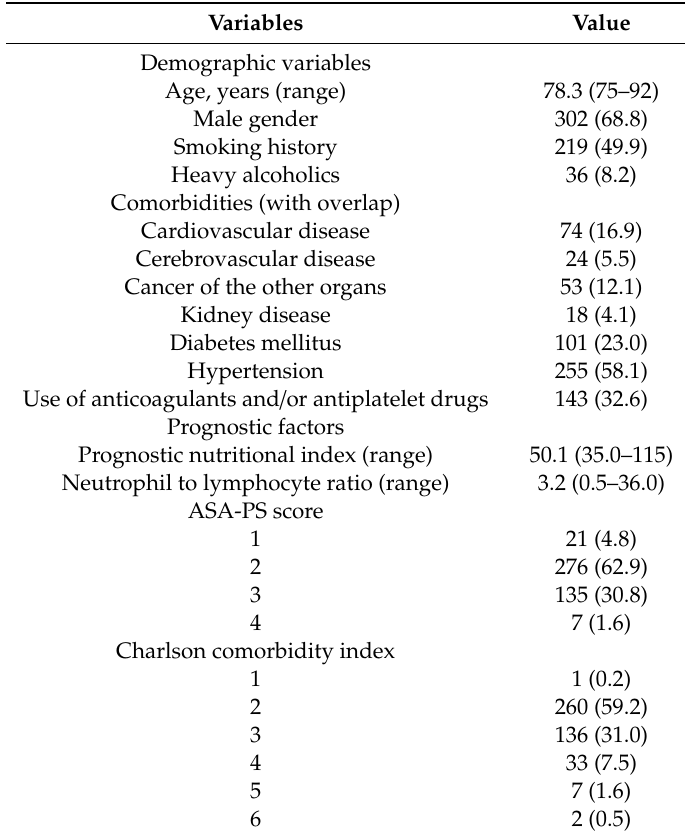
Table 1. Baseline characteristics of the 439 patients aged ≥ 75 years received endoscopic submucosal dissection (ESD) for early gastric cancer